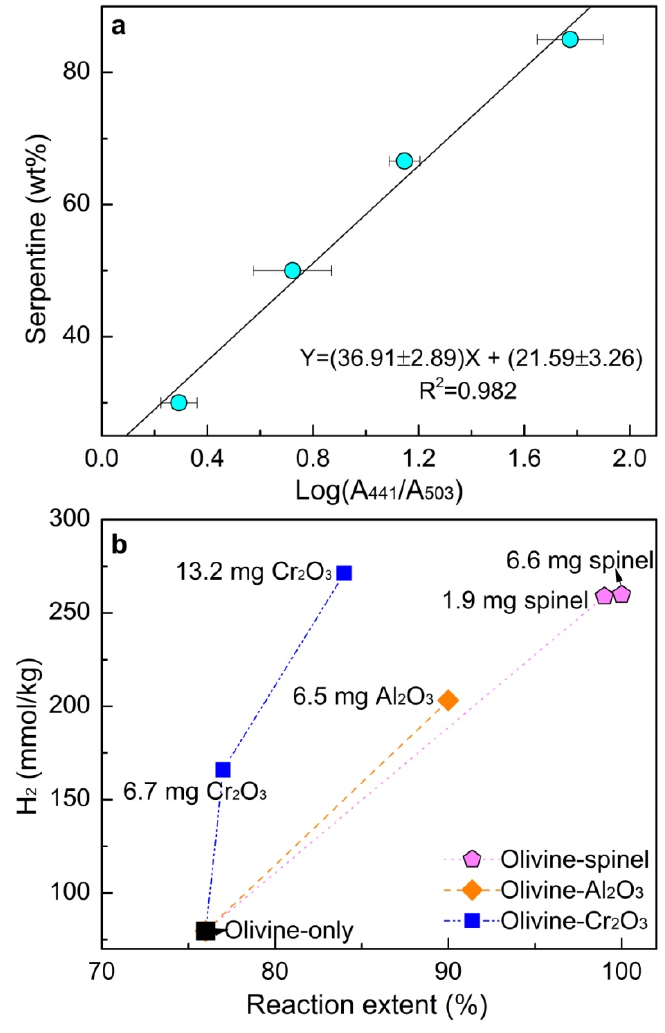
Figure 4. ( a ) Standard curves established to calibrate the proportions of serpentine in this study at 311 ◦ C and 3.0 kbar, with serpentine and brucite as major hydrous minerals. ( b ) Positive experiments of this study at 311 °C and 3.0 kbar, with serpentine and brucite as major correlation between the production of H 2 and the progress of reaction for experiments at 311 ◦ C and hydrous minerals. ( b ) Positive correlation between the production of H 2 and the progress 3.0 kbar, and the data correspond to experiments with a duration of 27–29 of reaction for experiments at 311 °C and 3.0 kbar, and the data correspond to experi- ments with a duration of 27–29 days.